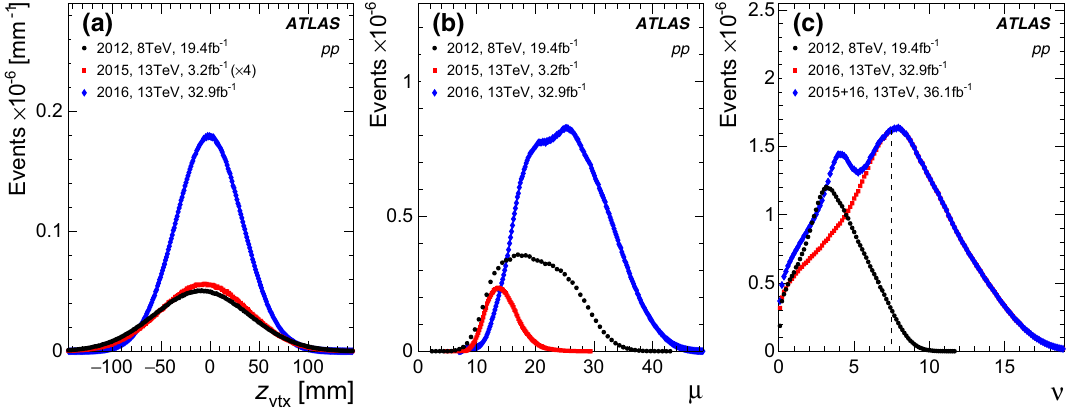
Fig. 1 Distribution of parameters: a vertex position z vtx , b instanta- neous luminosity parameter measured as the number of interactions per bunchcrossing μ , c theaveragenumberofpile-uptracksacceptedinthe